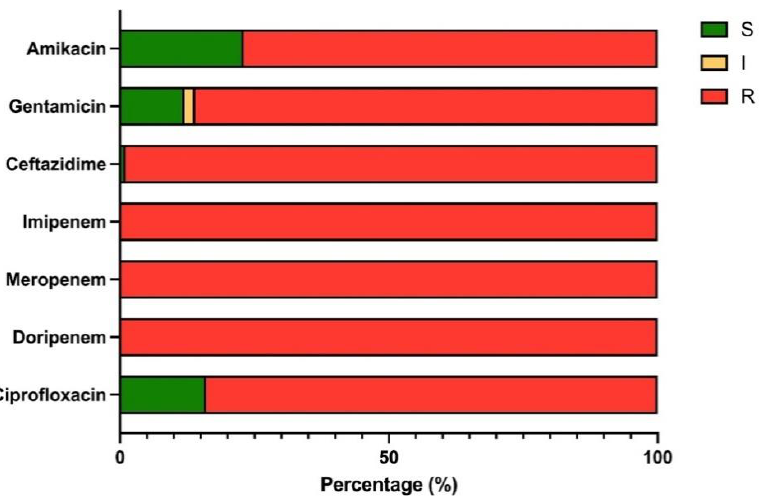
Figure 1. Antimicrobial susceptibility profiles of 172 carbapenem-resistant A. baumannii isolates in clinical samples are represented as a percentage. S: sensitive; I: intermediate; R: resistance. Table 1. Antibiogram pattern among carbapenem-resistance A. baumannii isolates. Antimicrobial Agents